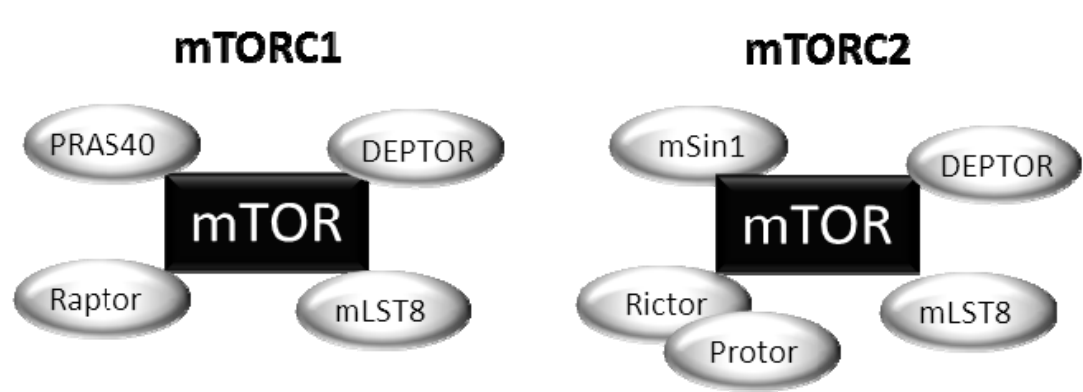
Figure 2. Schematic components of the mTOR complexes (mTORC). mTOR functions in two structural and functional distinct protein complexes: mTORC1, which contains two positive regulatory subunits, raptor and mLST8, and two negative regulators, PRAS40 and DEPTOR; and mTORC2, which contains rictor, mSin1 and Protor, and also mLST8 and